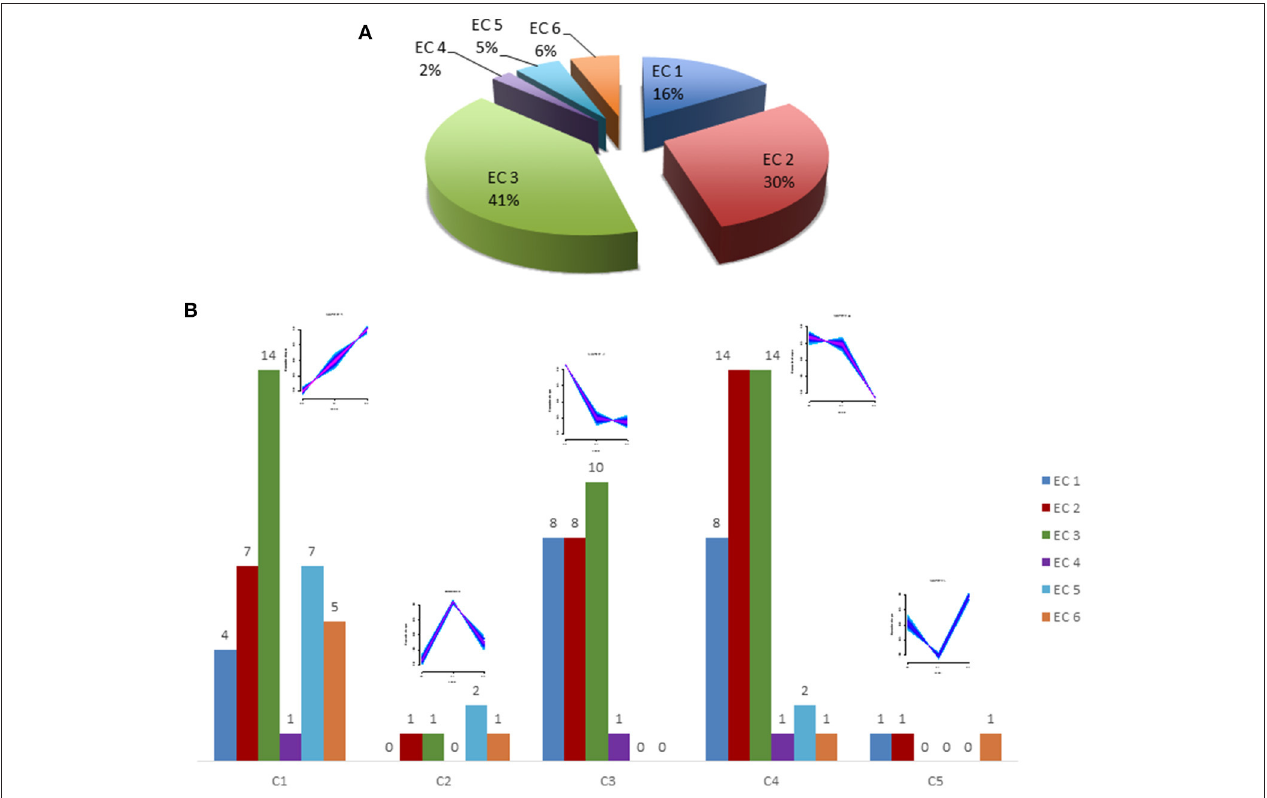
FIGURE 3 | Enzyme activity prediction. (A) A pie chart shows the predicted enzyme activity of six classes of enzymes for total rat neutrophil proteome. (B) A bar chart shows predicted enzyme activity for regulated proteins from all 5 clusters. EC 1 represents Oxidoreductases, EC 2–Transferases, EC 3–Hydrolases, EC 4–Lyases, EC 5–Isomerases, and EC 6–Ligases. A detail of the predicted enzymatic activities of these proteins is listed in Table 1 . The small images above each cluster show the general cluster pattern. For details on this see Figure 2